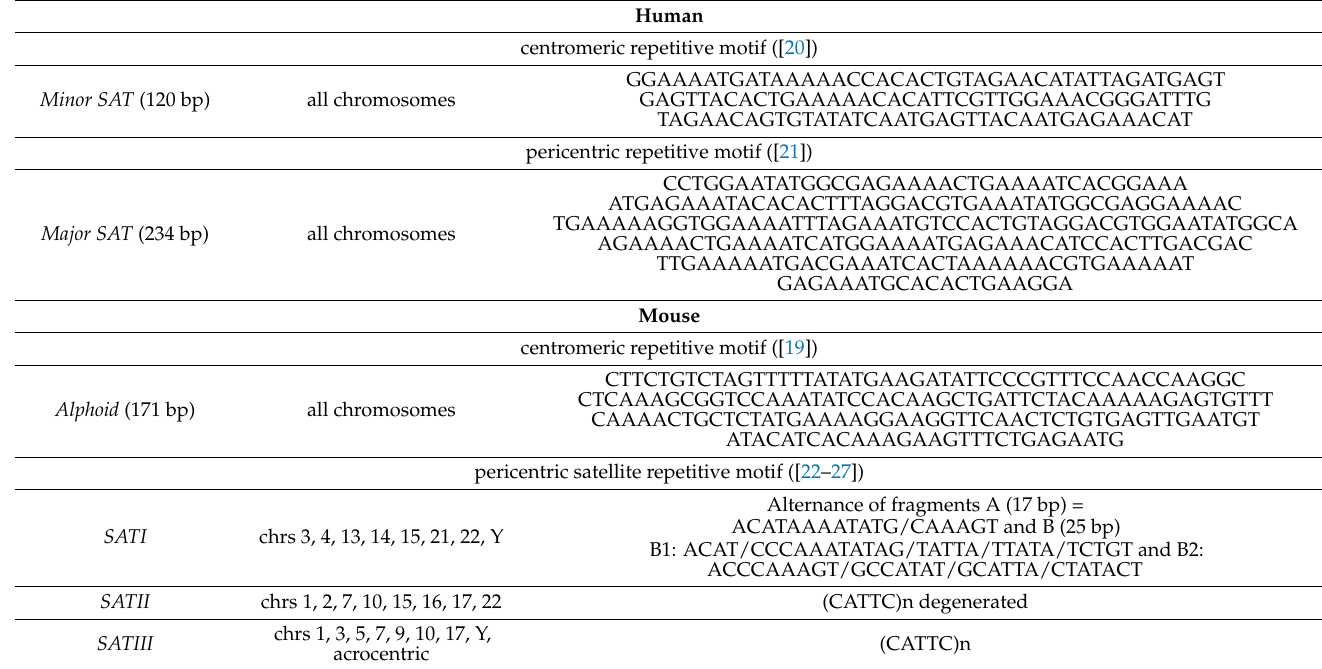
Table 2. General characteristics (sequence, size, chromosome distribution) of mouse and human satellite repetitive units of pericentric and pericentric